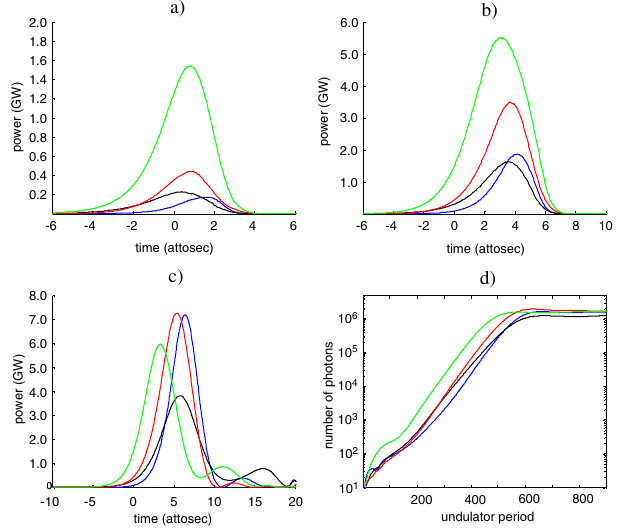
FIG. 3. (Color) Temporal FEL power profiles at (a) 400 undu- lator periods (12 cm), (b) 500 undulator periods (15 cm), and (c) 900 undulator periods (27 cm). (d) Integrated pulse energy expressed as total number of center-wavelength photons versus undulator